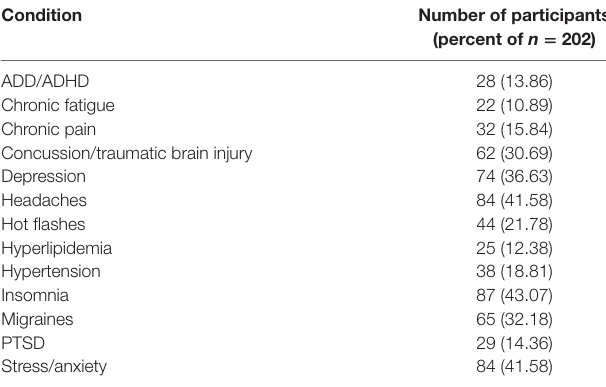
TaBle 1 | Self-reported health conditions of study participants.